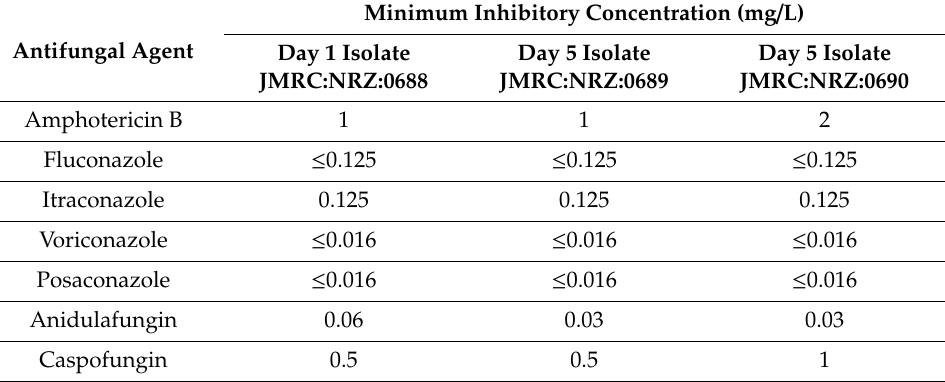
Table 1. In vitro susceptibility of the patient’s isolates.